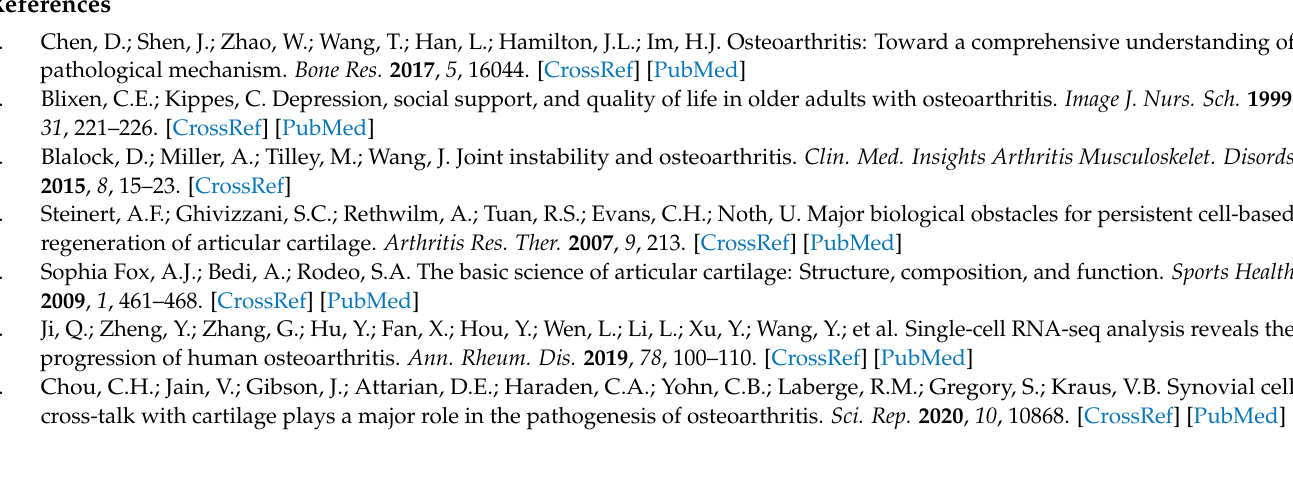
Figure S2: Characterization of connective tissue-forming cells in the joint, Figure S3: Comparison of chondrocytes to other connective tissue-forming cells, Figure S4: Characterization of chondro- cyte subpopulations, Figure S5: Proteoglycans and Wnt signaling pathway genes are differentially expressed between chondrocyte subpopulations, Figure S6: TGF β /BMP signaling pathway genes and regulators of mesenchymal cell proliferation are differentially expressed between chondrocyte subpopulations, Figure S7: Characterization of chondrocyte subpopulations from injured and unin- jured knee joints, Figure S8: Cellular and molecular changes at 3 days post-injury (3DPI), Figure S9: Genes upregulated after injury, Figure S10: Genes downregulated after injury, Figure S11: Expan- sion of Chil1 expressing region after injury, Table S1: Genes enriched in chondrocytes compared to other connective tissue-forming cells, Table S2: Potential OA targets enriched in chondrocytes compared to other connective tissue-forming cells, Table S3: Potential OA targets enriched in